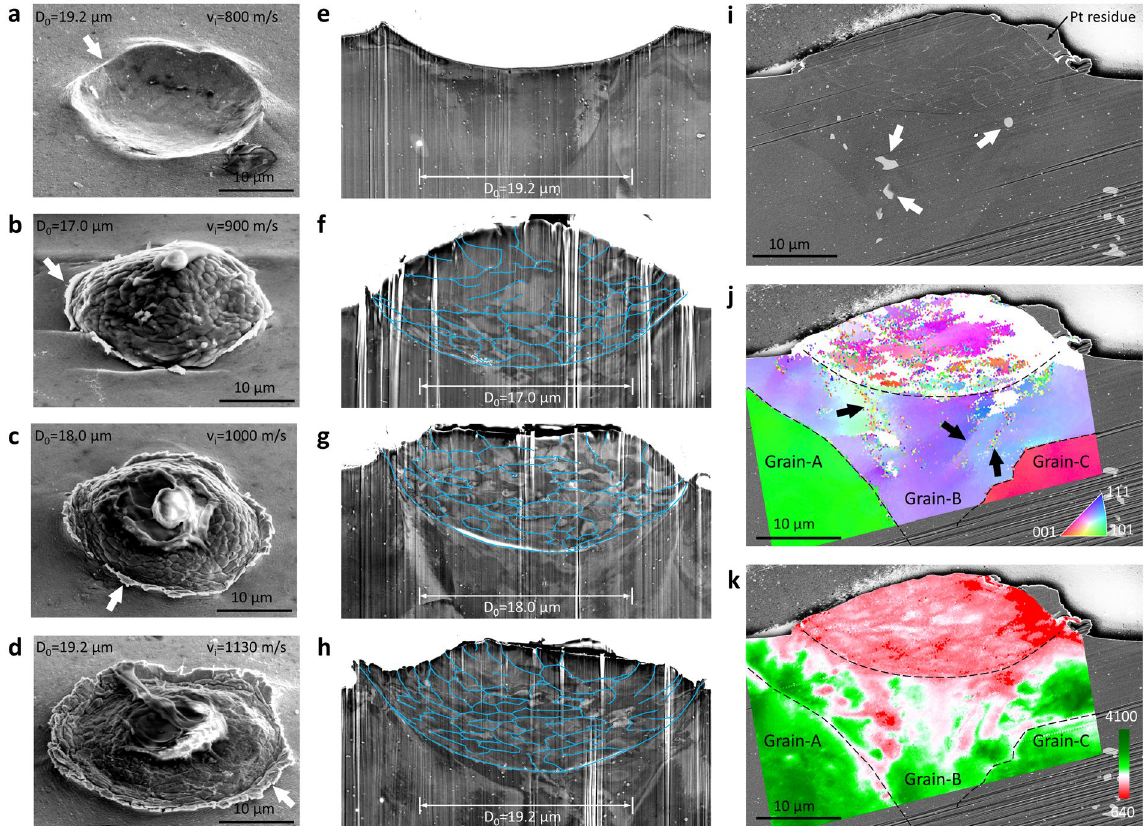
Figure 6. The cross-sectional study of aluminum particles collided on aluminum. ( a–d ) Same-magnification SEM images after 800, 900, 1,000, and 1,130 m/s impacts to Al-substrate. PDMS residues are present on the top surface of each Al-particle. ( e–h ) Contrast-enhanced cross-sectional SEM images of the impact samples in ( a– d ) with identified GBs in blue lines. Each image is scaled to make D 0 the same length. Corresponding original SEM images are shown in Fig. S2. ( i ) A cross sectional SEM image of an Al-particle after a 960 m/s impact to an aluminum surface with